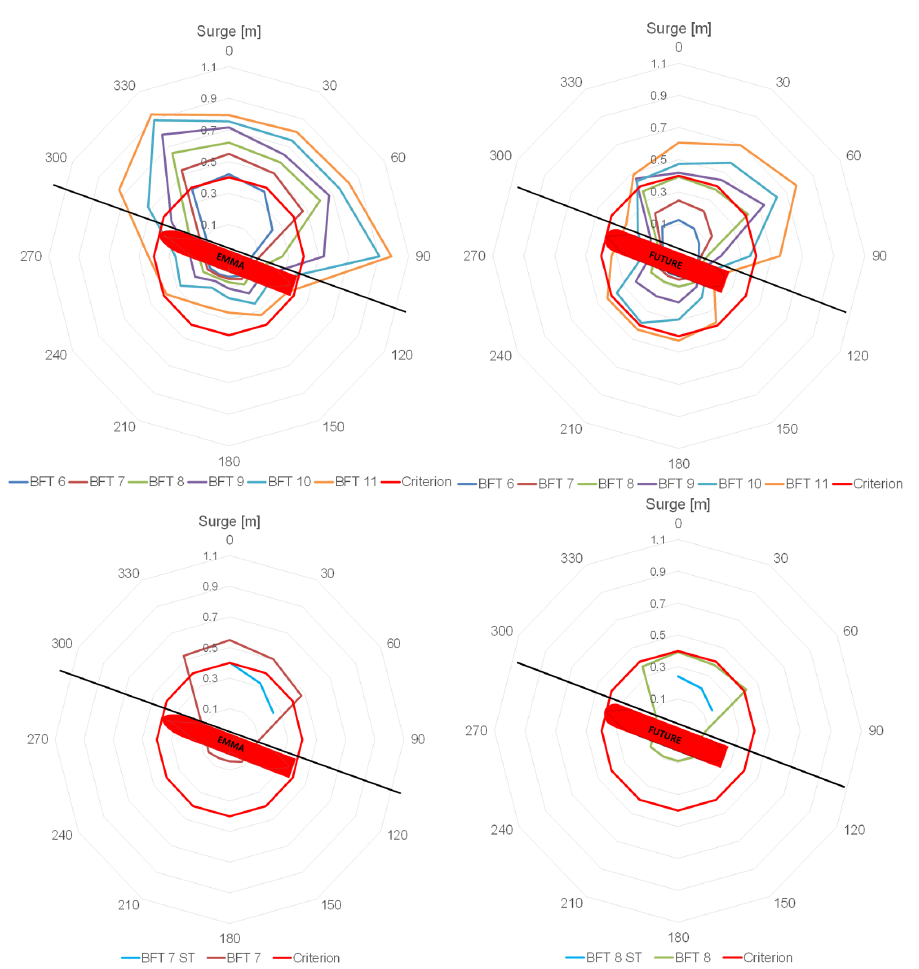
Figure 10. Significant surge motion results for dynamic wind conditions with and without ShoreTension ®